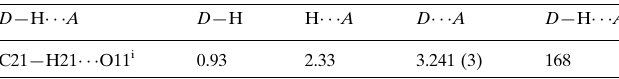
Hydrogen-bond geometry (A ˚ , (cid:2)